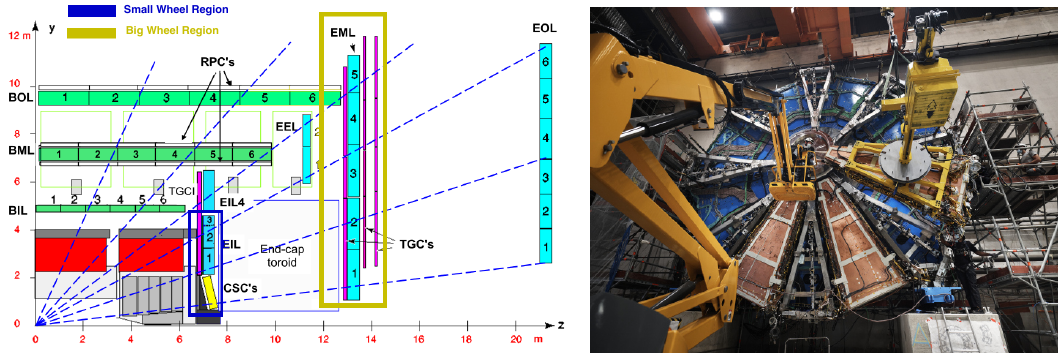
Figure 1: One of several detector systems in the ATLAS Muon Spectrometer (left), the New Small Wheel [ 3 ] is currently being assembled at CERN